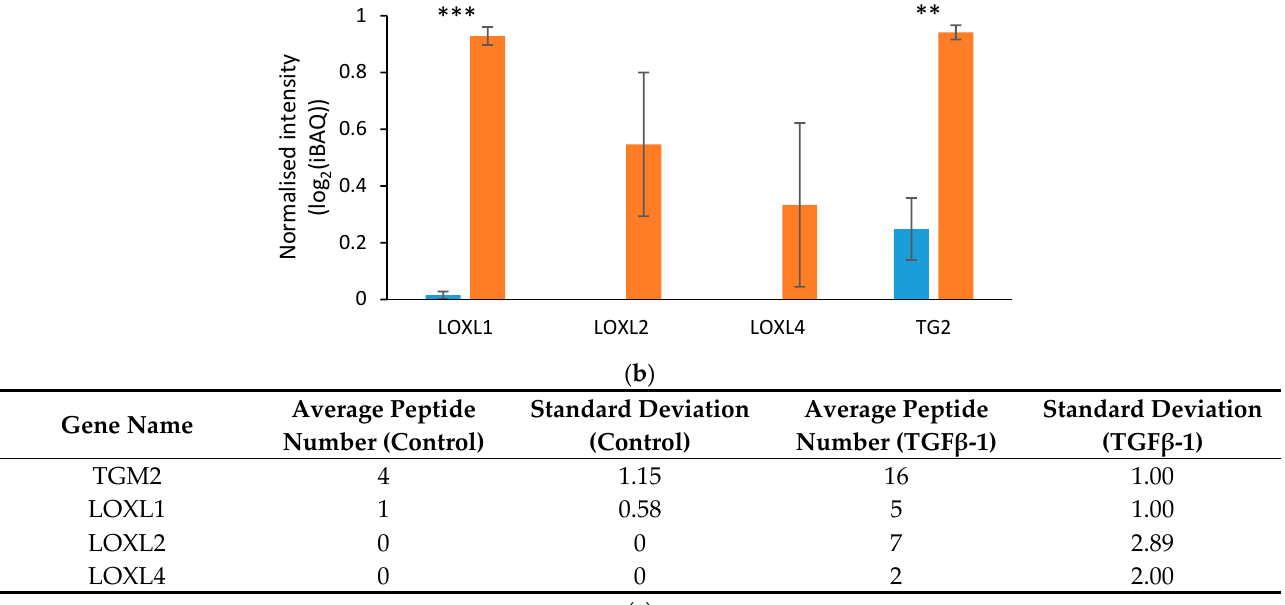
Figure 1. Proteomic analysis of cross-linking enzymes identified in dermal fibroblast ECM after 20 days of TGF β -1 stimulation. A one-tailed, unpaired t-test was used to analyse the statistical significance of differences in protein abundance between control (blue bars) and TGF β -1 treated (orange bars) cells ( n = 3). ( a ) unnormalised iBAQ values (LOXL2: p = 0.002; TG2: p = 0.003); ( b ) normalised TG2 iBAQ values (LOXL1: p = 8.64 × 10 − 5 ; TG2: p = 0.003); ( c ) average peptide numbers identified for each cross-linking enzyme and the corresponding standard deviations in control and TGF β -1-treated ECM preparations. Significant upregulations are marked with asterisks (two asterisks for p ≤ 0.01; four asterisks for p ≤ 0.0001).